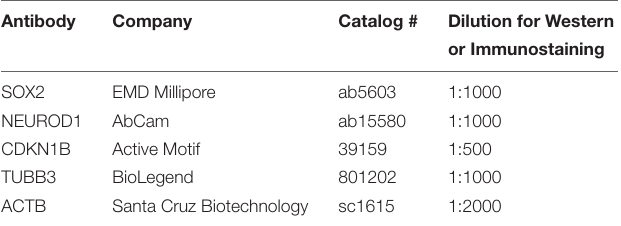
TABLE 2 | Antibodies for Western blot or